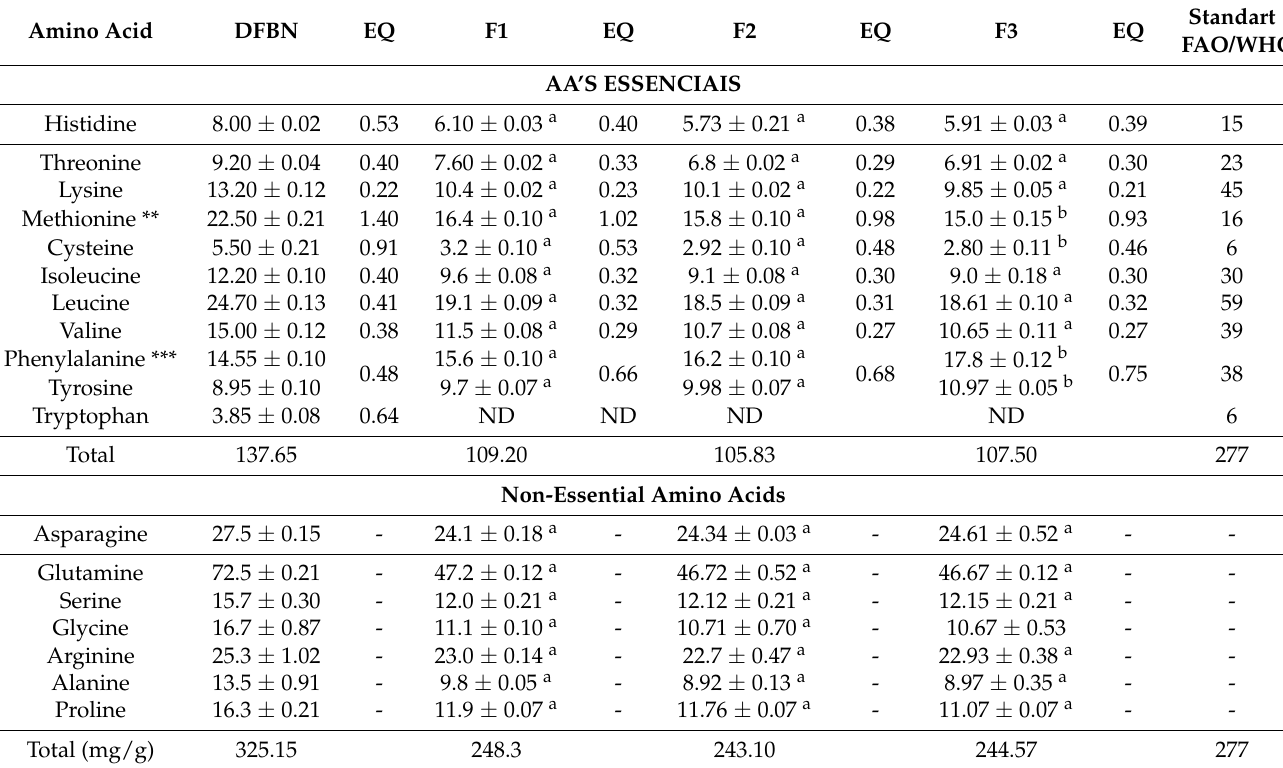
Table 4. Total amino acid content (mg/g protein) of Defatted Flour of Brazil Nuts and bar formulations related to the reference standard [10] * and chemical